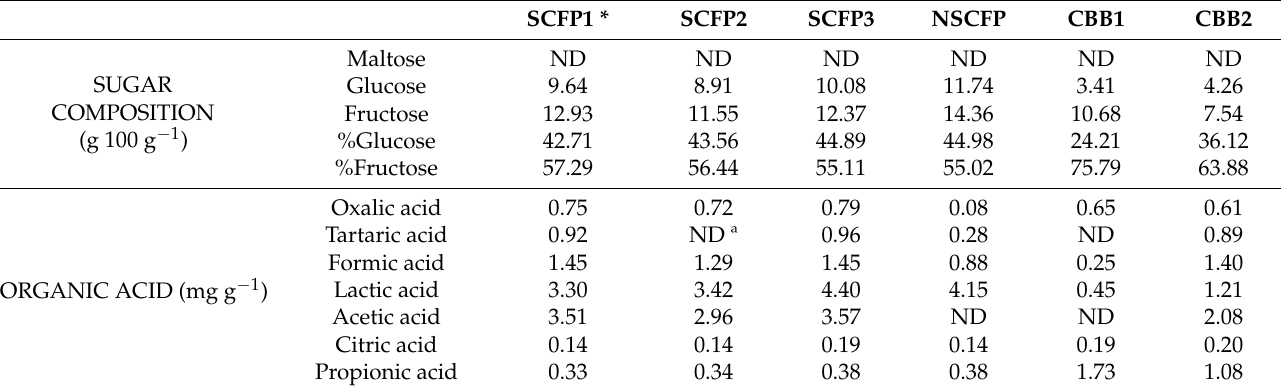
Table 2. Sugar and organic acid profile of bee